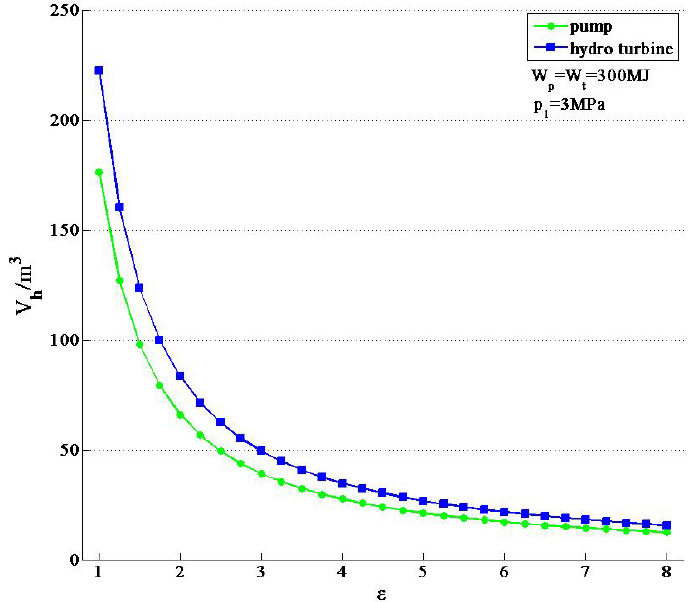
Figure 10. Pre-set pressure various with water-air volume